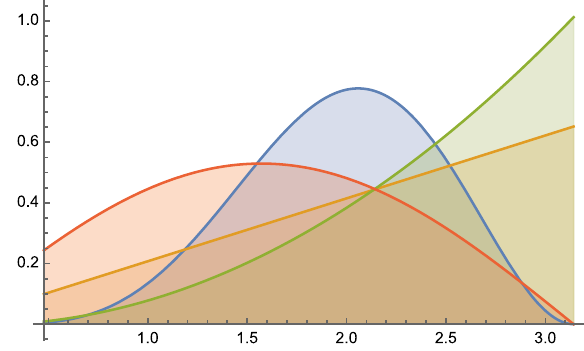
Fig. 15 Example 6, f ( x )/µ (in blue) superimposed with the three pdfs used for MIS